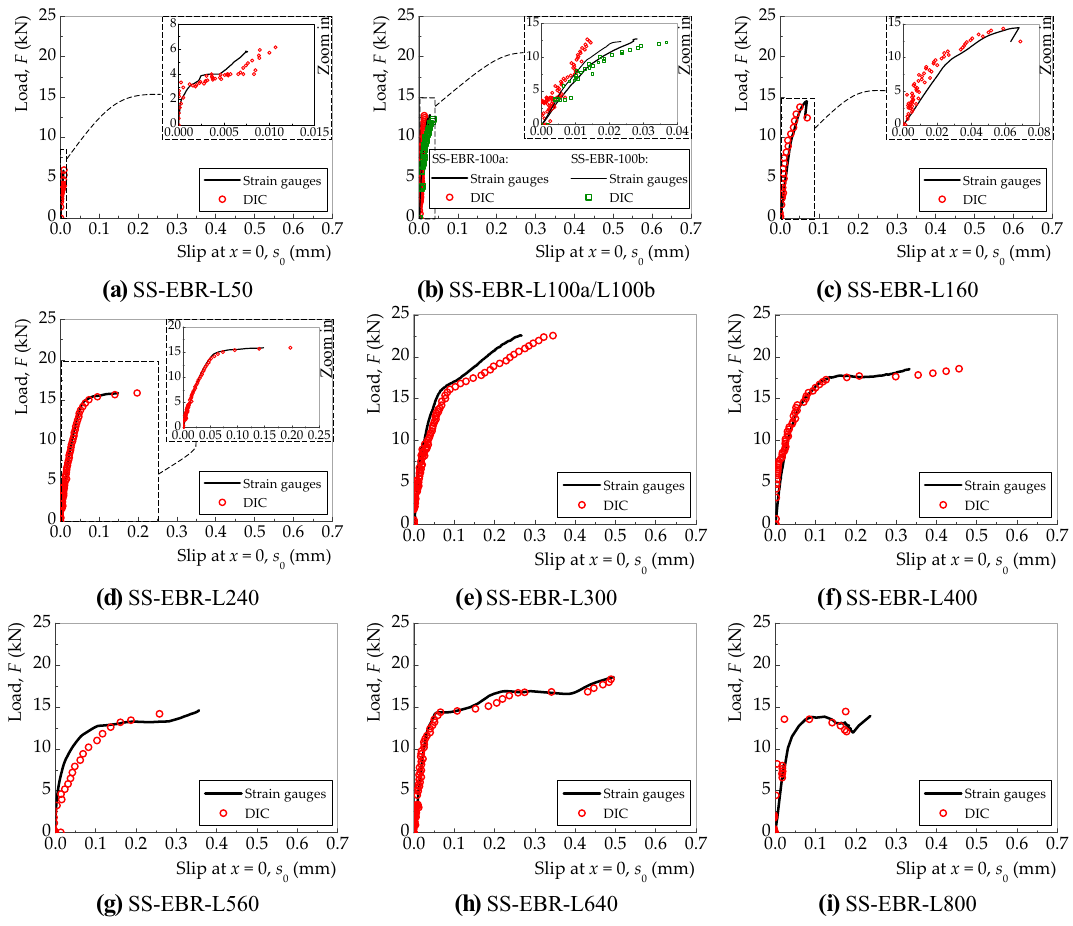
Fig. 8 Load–slip responses of the EBR